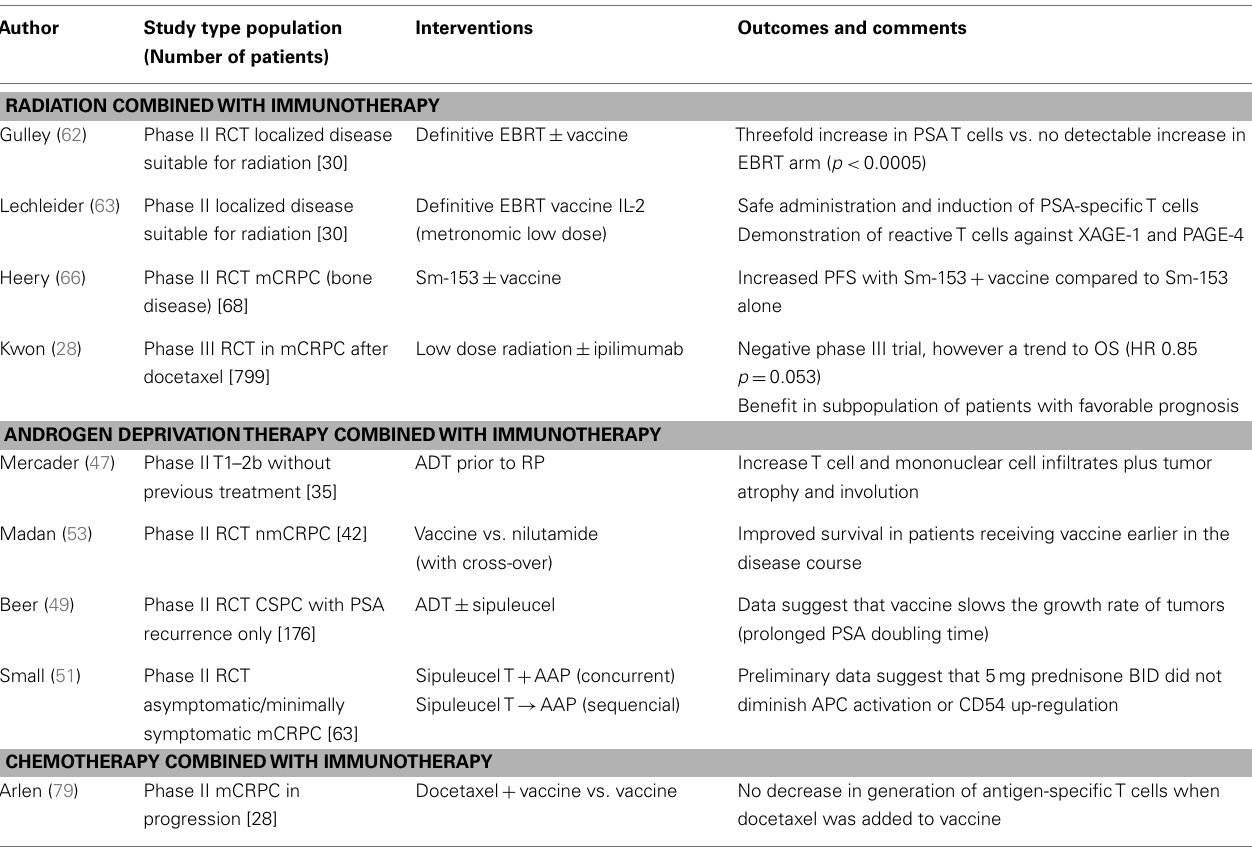
Table 2 | Clinical trials using immune combinations in prostate cancer